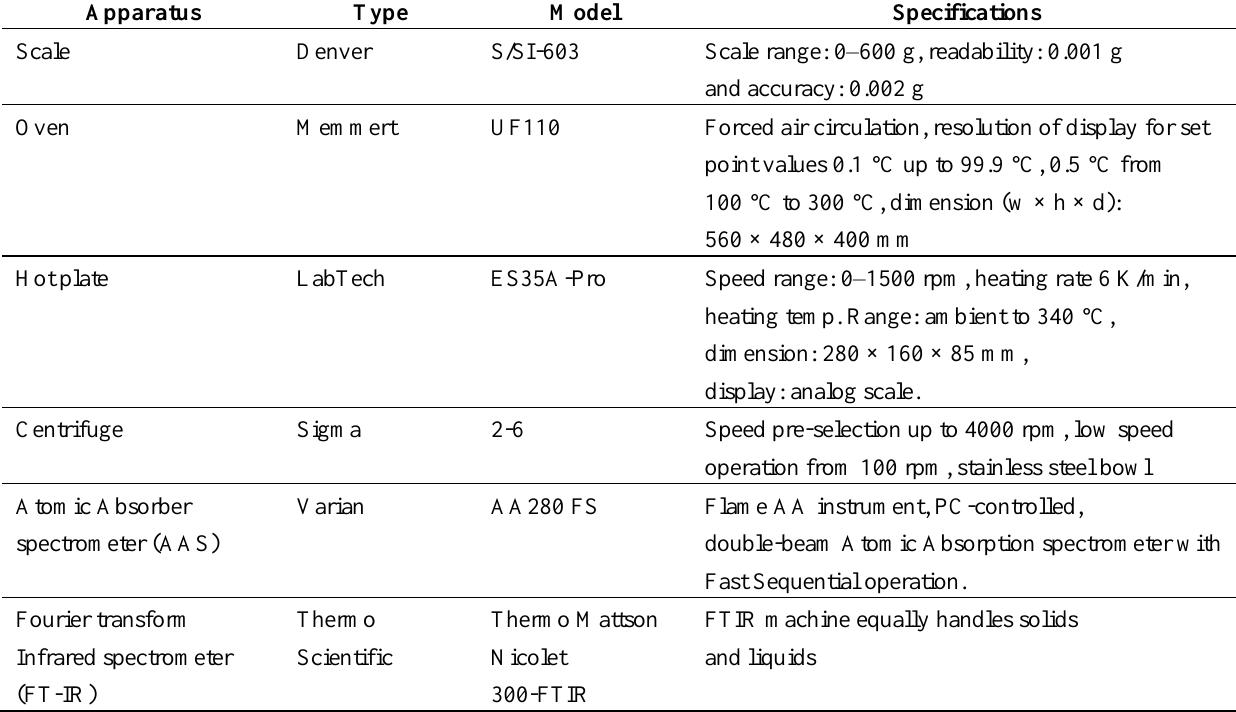
Table 1. Specifications of the apparatus used in the